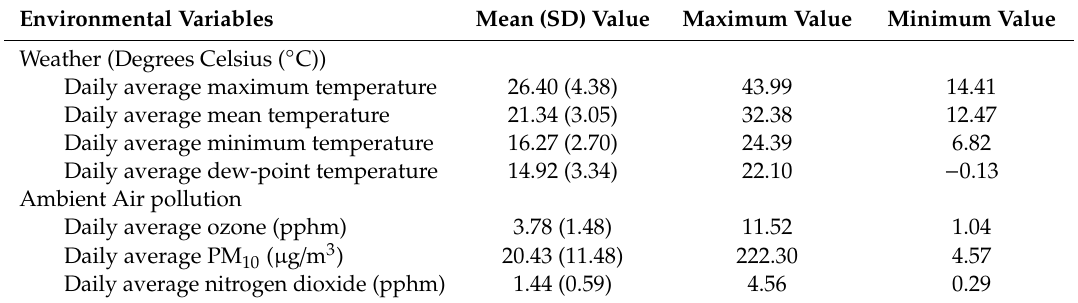
Table 1. Descriptive statistics for environmental variables in the SSD during the warm season, 2001 to 2013.